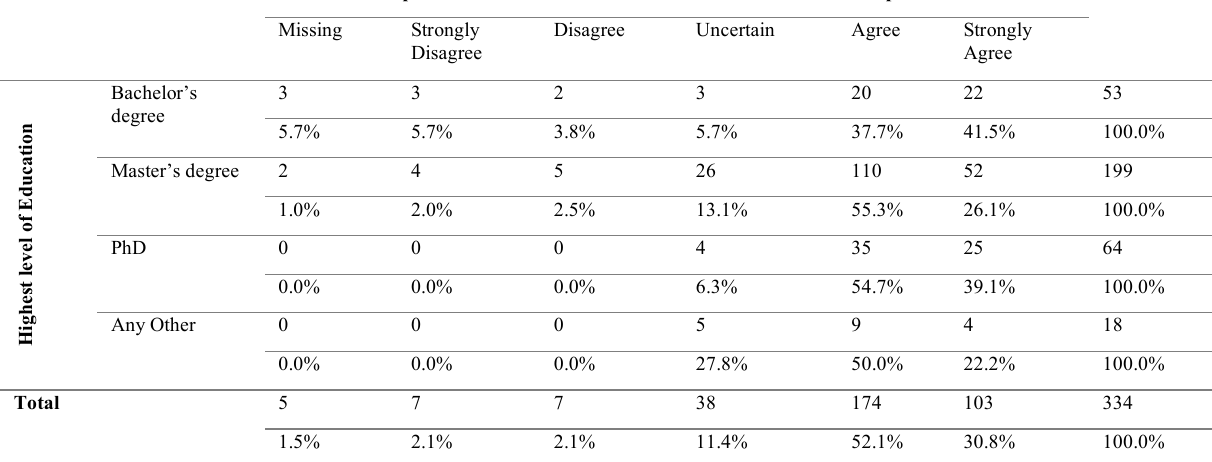
Table 4: Cross-Tabulation between Education and AUDIND